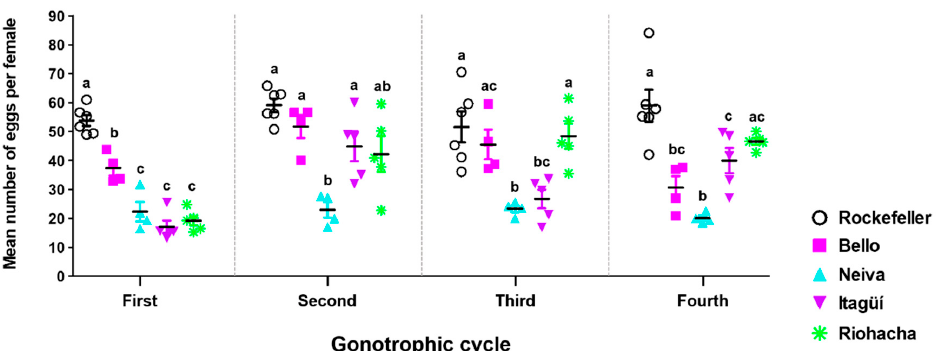
Figure 6. Fecundity per gonotrophic cycle of Colombian Ae. aegypti populations reared at 28 ± 1 °C temperature, 80 ± 5% relative humidity, and 12 h light: 12 h dark photoperiod. The mean and standard error of the mean were plotted. Each point represents a replicate that started from a cohort of 100 eggs. The total number of replicates were: Bello and Neiva (4); Itagüí and Riohacha (5), and control Rockefeller (6). One-way analysis of variance (ANOVA) was conducted, followed by a Bonferroni post-hoc test to account for multiple comparisons between Ae. aegypti populations. Populations sharing the same letters are not significantly different ( p >